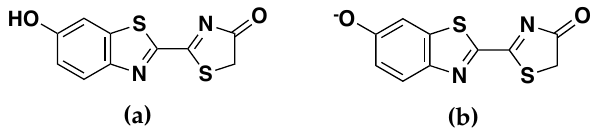
Figure 1. Structures of the ( a ) neutral (OLU) and ( b ) anionic (OLU − ) forms of